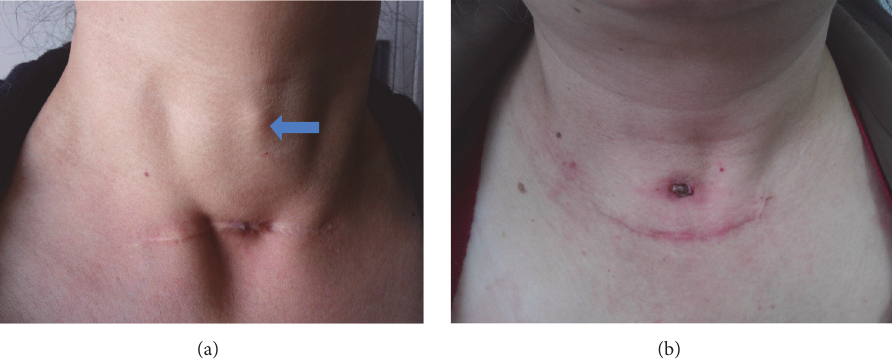
Figure 1: Clinical photograph of postthyroidectomy skin sinus formation. (a) Sinus was located in primary thyroid surgery incision line; (b) sinus was located above the primary thyroid surgery incision line; arrow: abscess under the